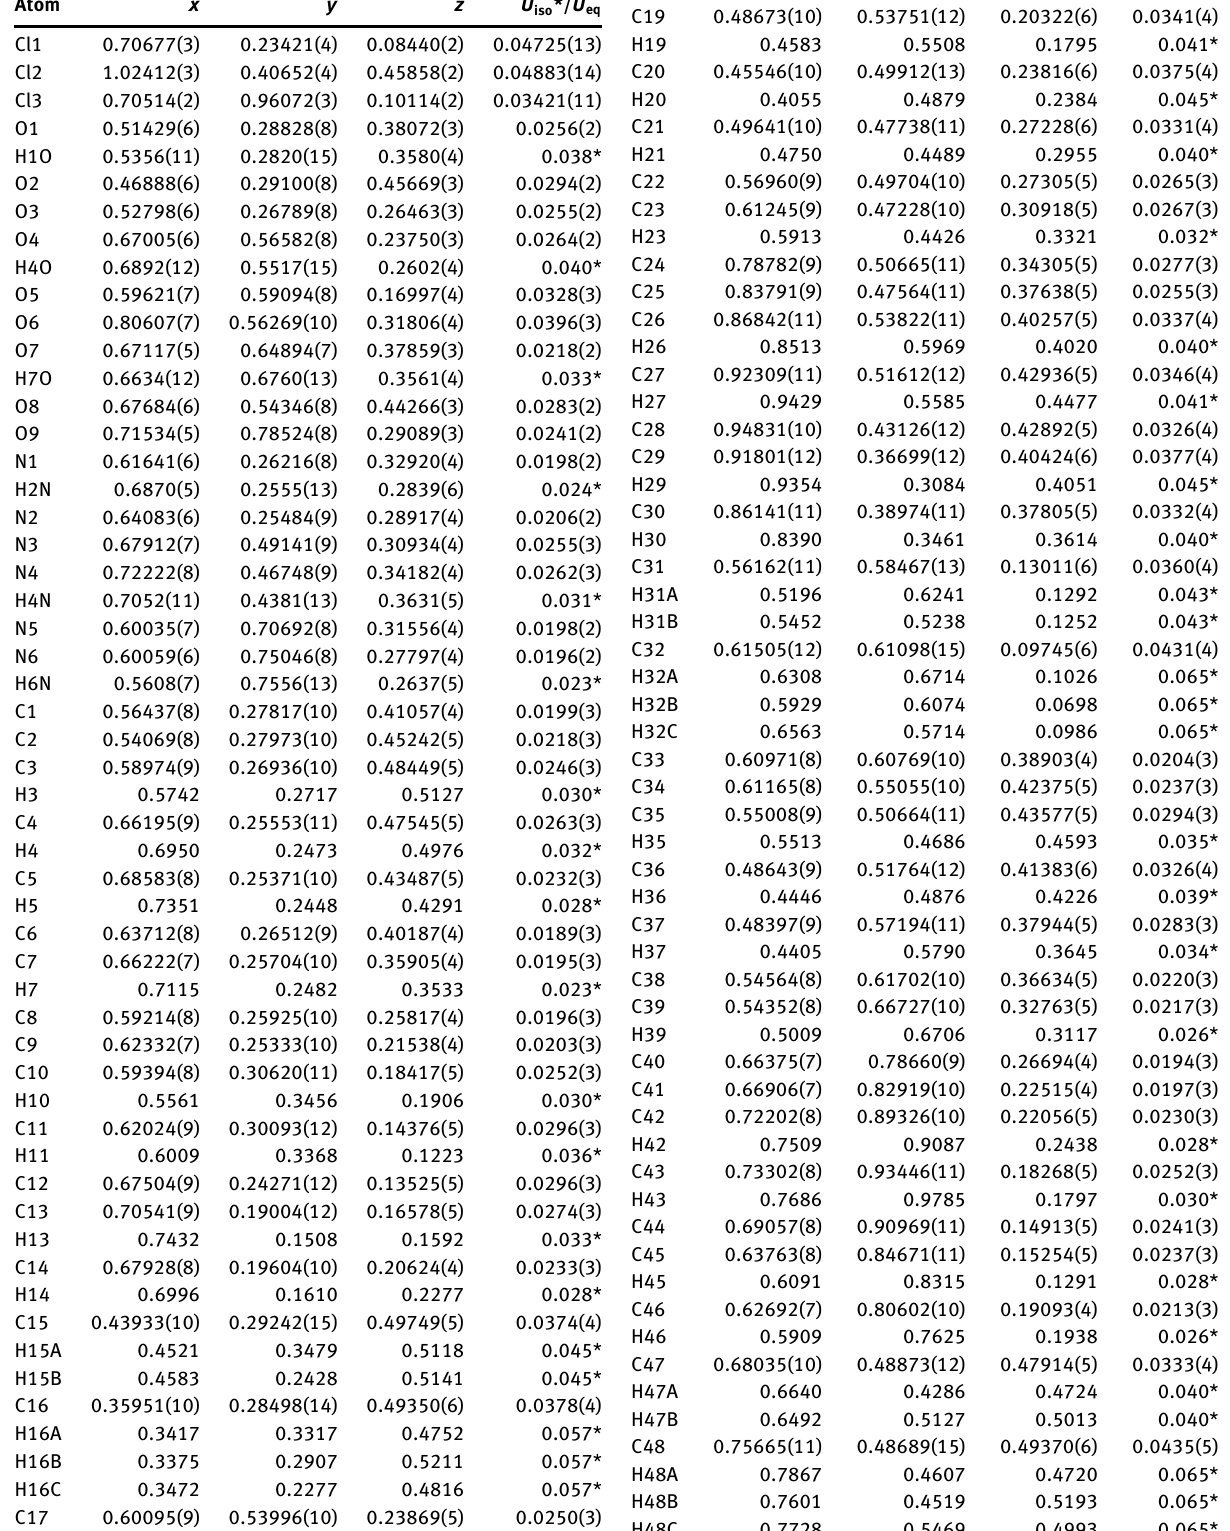
Table 2: Fractional atomic coordinates and isotropic or equivalent isotropic displacement parameters (Å 2